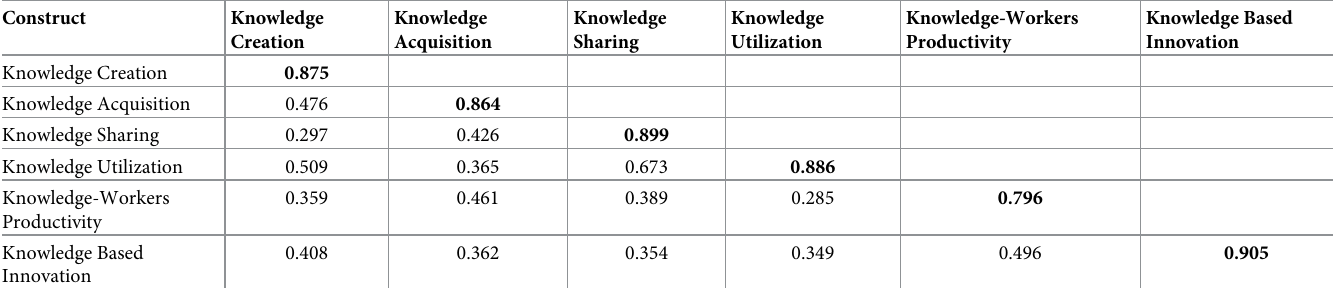
Table 3. Discriminant validity.